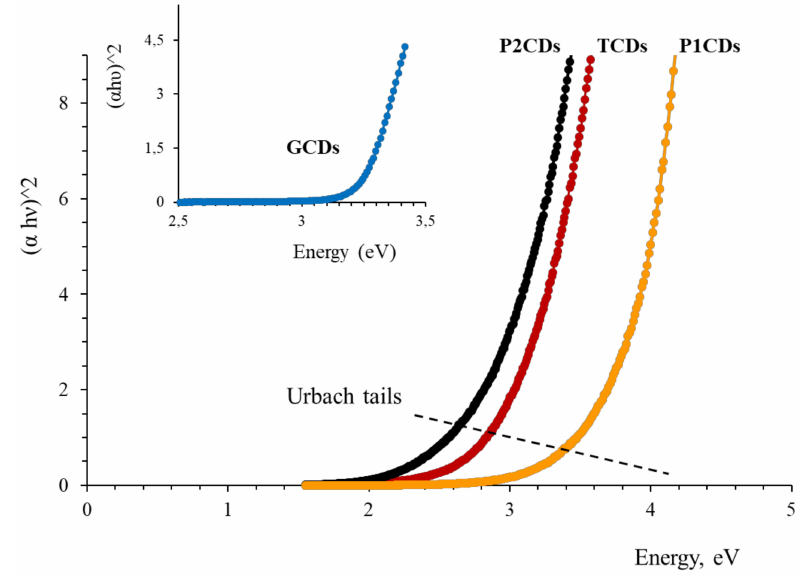
Figure 4. Tauc plots for estimation of the CDs